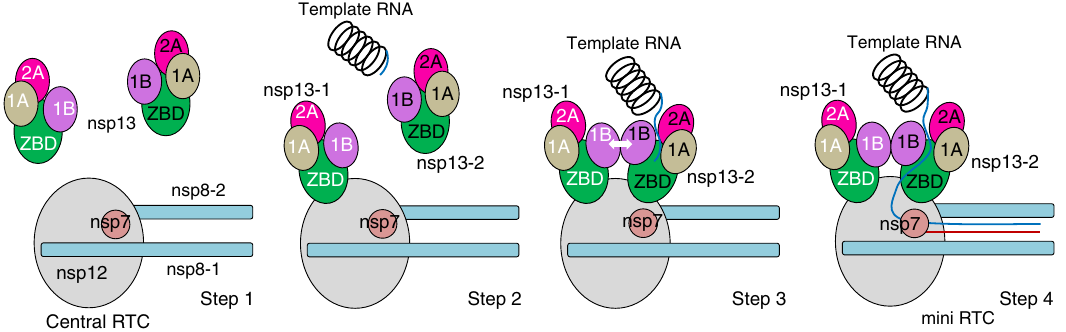
Fig. 4 A proposed model for the helicase-polymerase coupling in the formation of SARS-CoV-2 RTC. Nsps composed mini RTC and template-primer RNAs are shown as schematic diagrams. Step 1, nsp12 bound nsp7, and nsp8 to constitute central RTC, waiting for a template RNA unwinding. The nsp13 molecule keeps in an inactive state. Step 2, an nsp13 (nsp13-1) contacts central RTC to form a platform to recruit the nsp13-2. Step 3, nsp13-2 is assembled into mini RTC, and contacts with nsp13-1, allowing the bound RNA translocating towards nsp12 activity center. Step 4, the unwinded single-strand RNA template passes through the RNA-binding channel of nsp13-2 and extends to nsp12 active center for the subsequent nascent